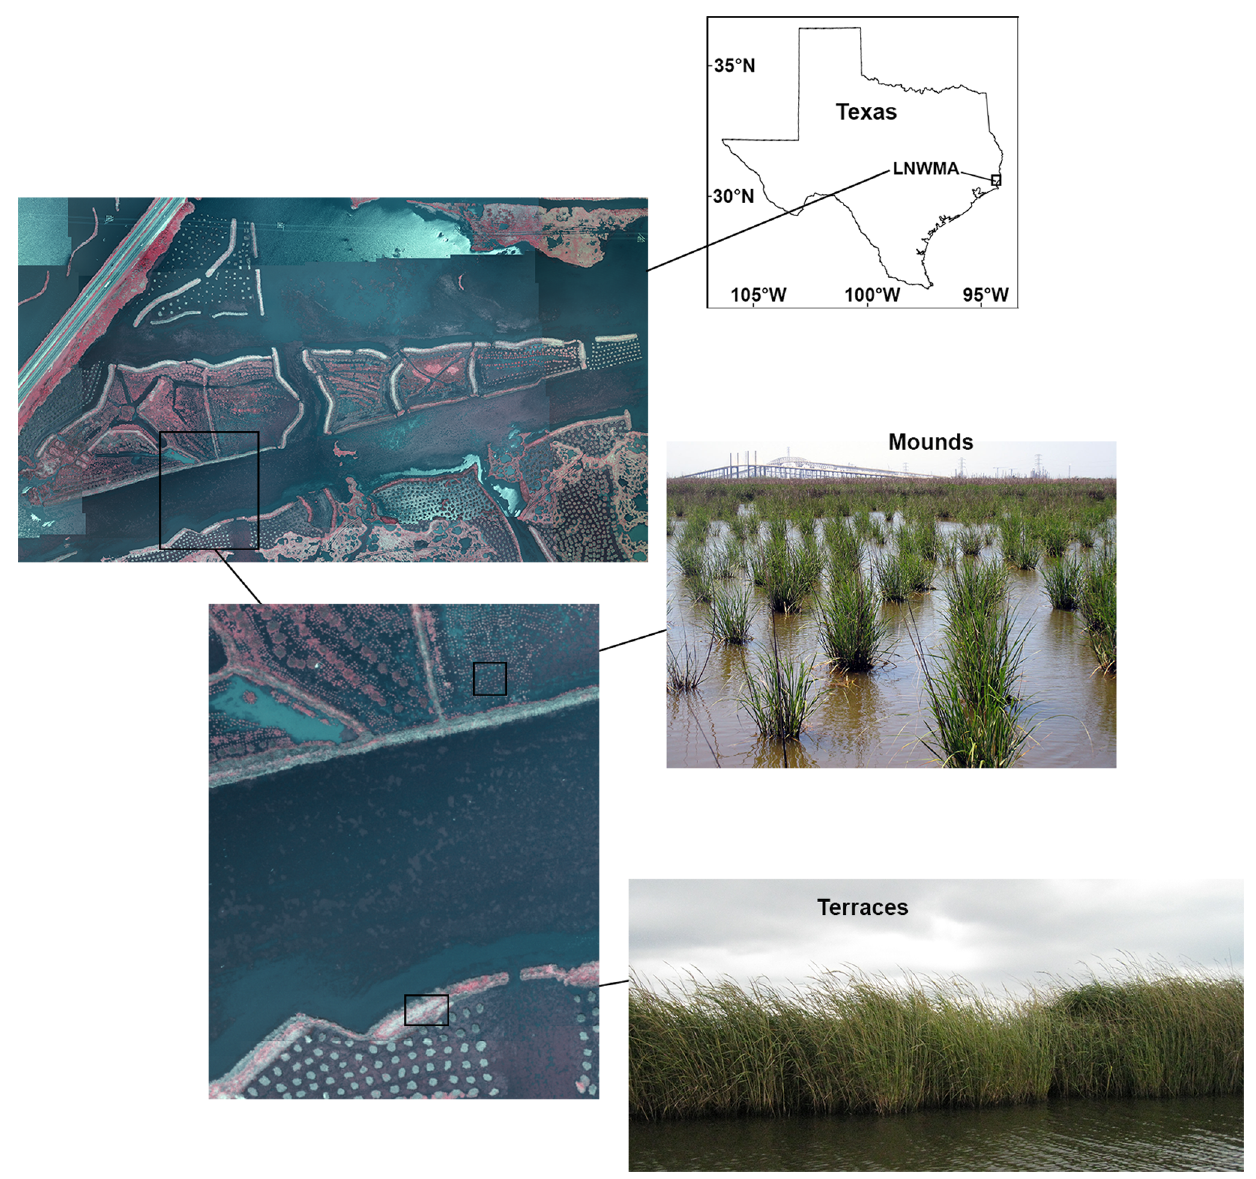
Figure 1. Map of study site. Infrared aerial images taken during a flyover of the marsh restoration project in the Lower Neches Wildlife Management Area (LNWMA) in September 2009, and ground-level pictures of terraces (large patches) and mounds (small patches).